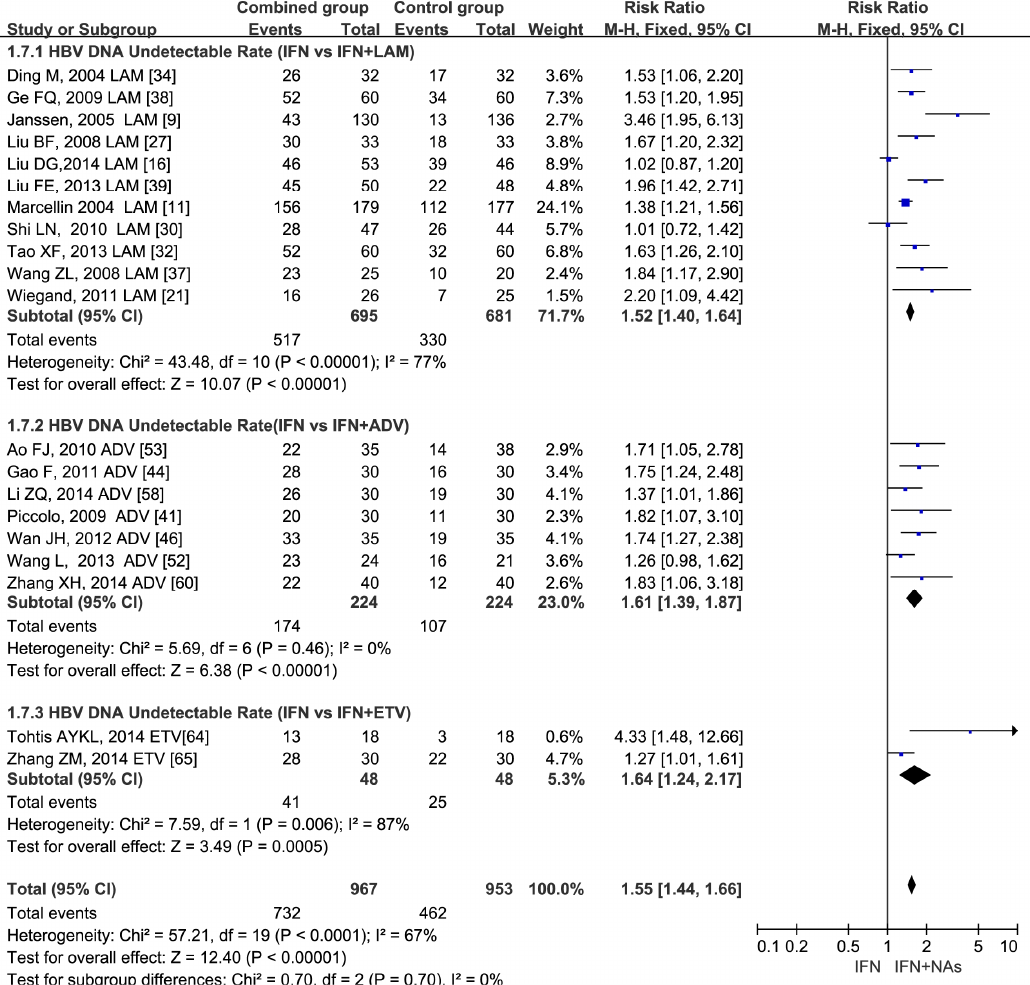
Figure 2. Forest plot of 1920 patients of 20 studies in HBV DNA undetectable rate between IFN and